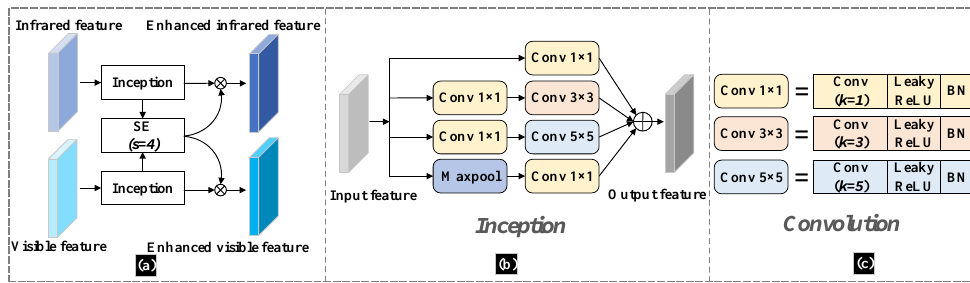
Figure 4. The structure of the Attention fusion module. ( a ) shows the data flow structure of the attention fusion. ( b ) shows the Inception structure in ( a ), which mainly connects the 4 branches. ( c ) shows the detailed description of the convolution structure in ( b